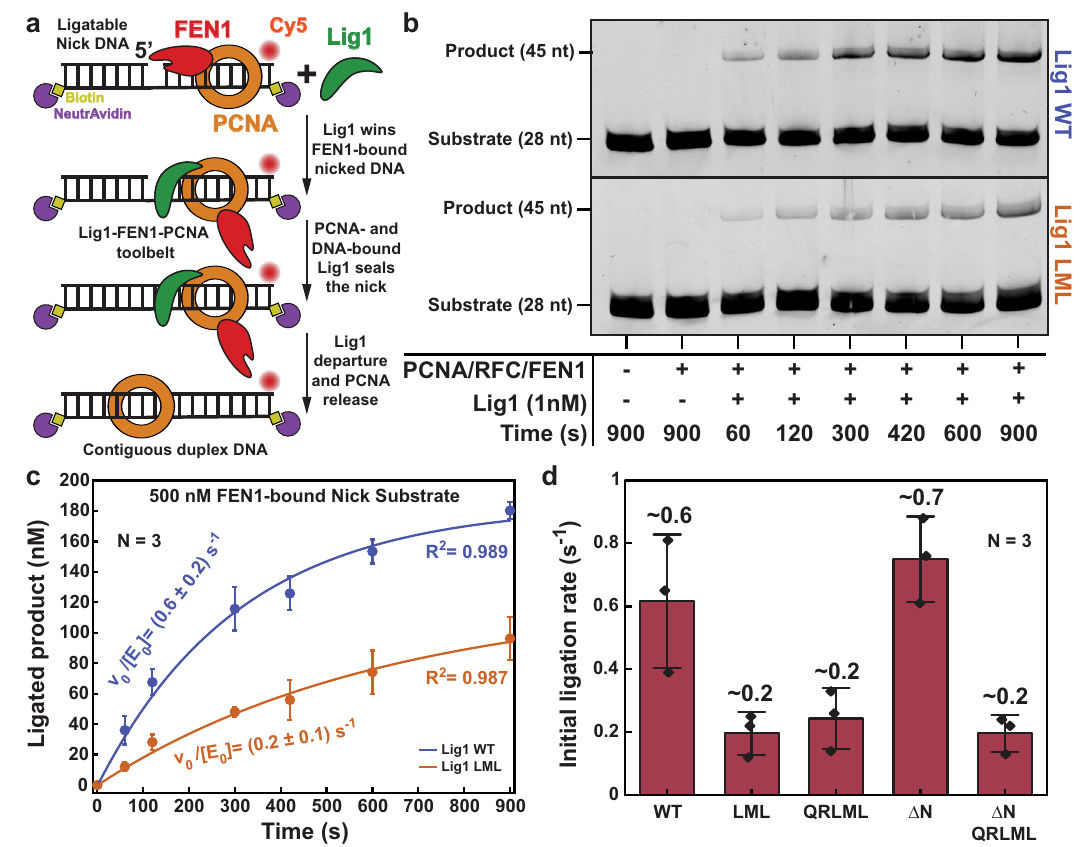
Fig. 4 | PCNA interaction-dependent modulation of Lig1 ligation rates in the presence of FEN1. a Schematics of the experiment shown in panel ( b ). b Multiple- turnover ligation by Lig1 in the presence of trapped PCNA and competitor FEN1. A double-blocked (NeutrAvidin bound to both DNA termini; 1 µ M NeutrAvidin) DNA nick substrate (500nM) was used for this experiment. PCNA (500nM) was loaded onthissubstratebyRFC (500nM).FEN1 D181A(500nM)wasaddedand incubated with the PCNA-loaded substrate. The reaction was initiated by adding WT_Lig1 or LML_Lig1 (1nM) and incubated for the indicated amount of time at 37°C. c Quanti fi cationofthedatafrompanel( b )asdescribedintheMethodssection.The single-exponential burst parameters are irrelevant kinetically and only their